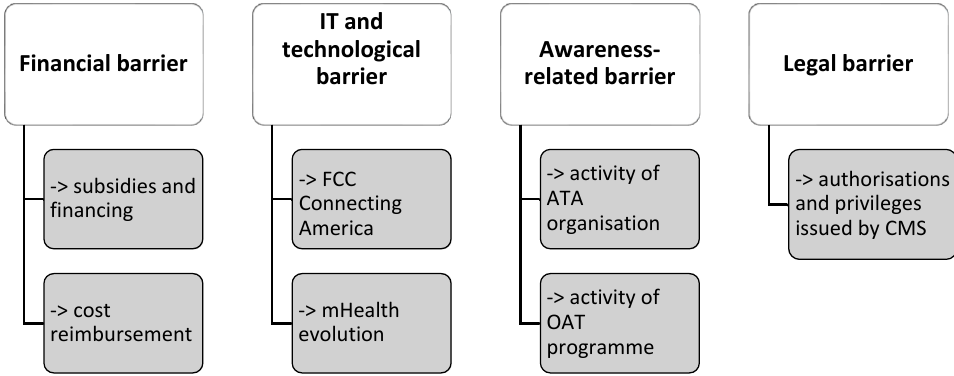
Figure 4. Solutions introduced in the United States to minimise barriers [24].